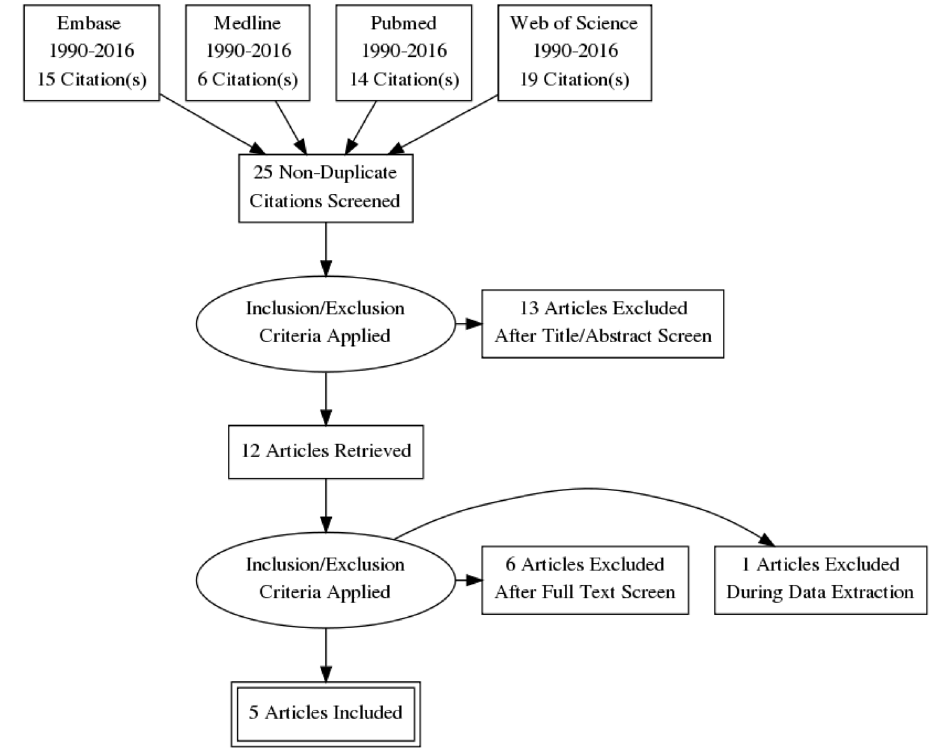
Figure 1. This PRISMA Chart was constructed to illustrate the workflow of the review